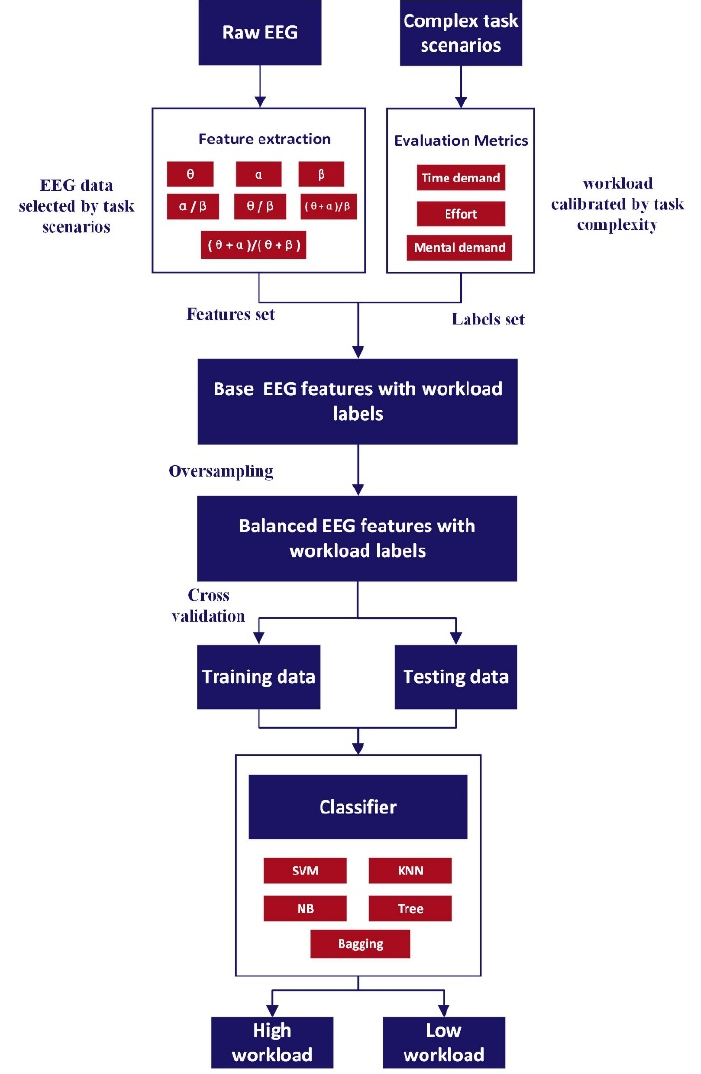
Figure 8. Seafarers’ workload recognition algorithm framework.